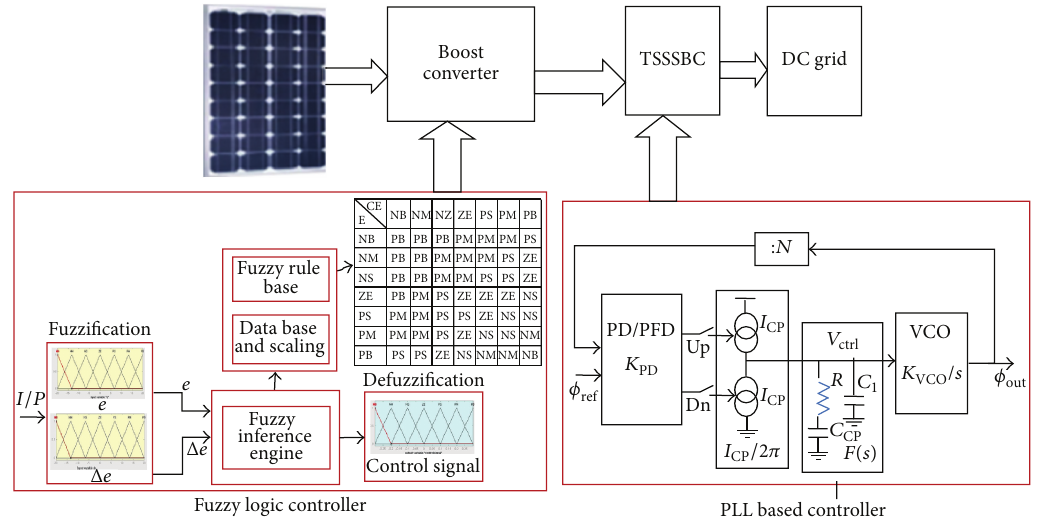
Figure 1: Block diagram of cascaded converter fed PV array connected to